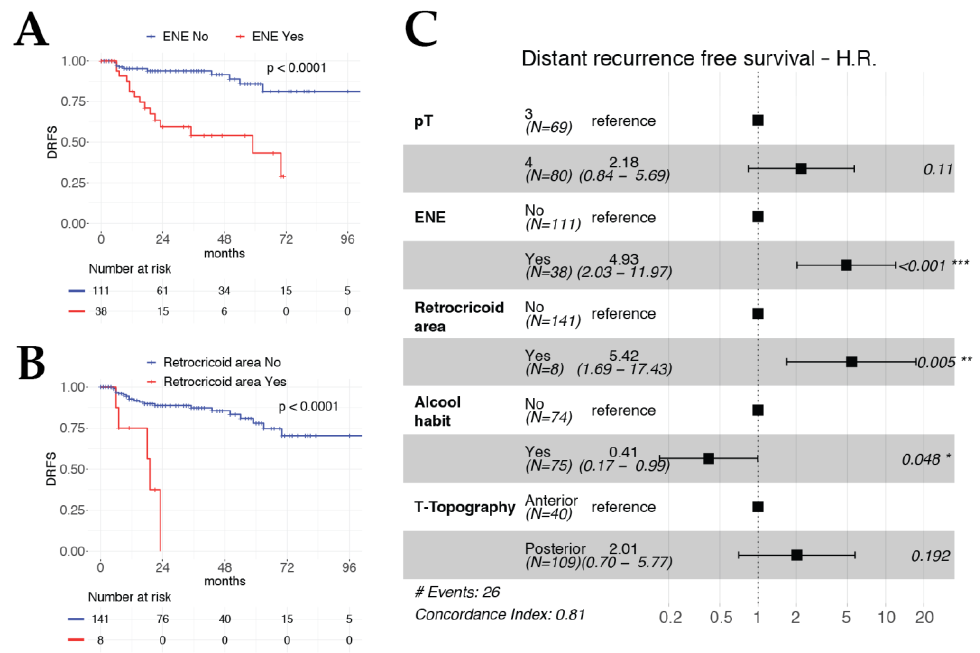
Figure 3. Kaplan–Meier curves for DRFS according to ENE status ( A ) and retro-cricoid area involvement ( B ). Forest plot of DRFS multivariable model ( C ).